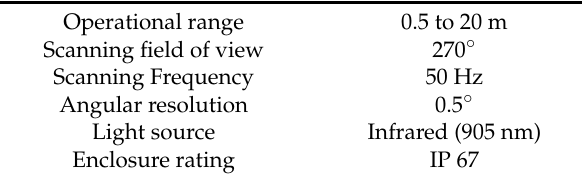
Table 1. LMS111 technical data.